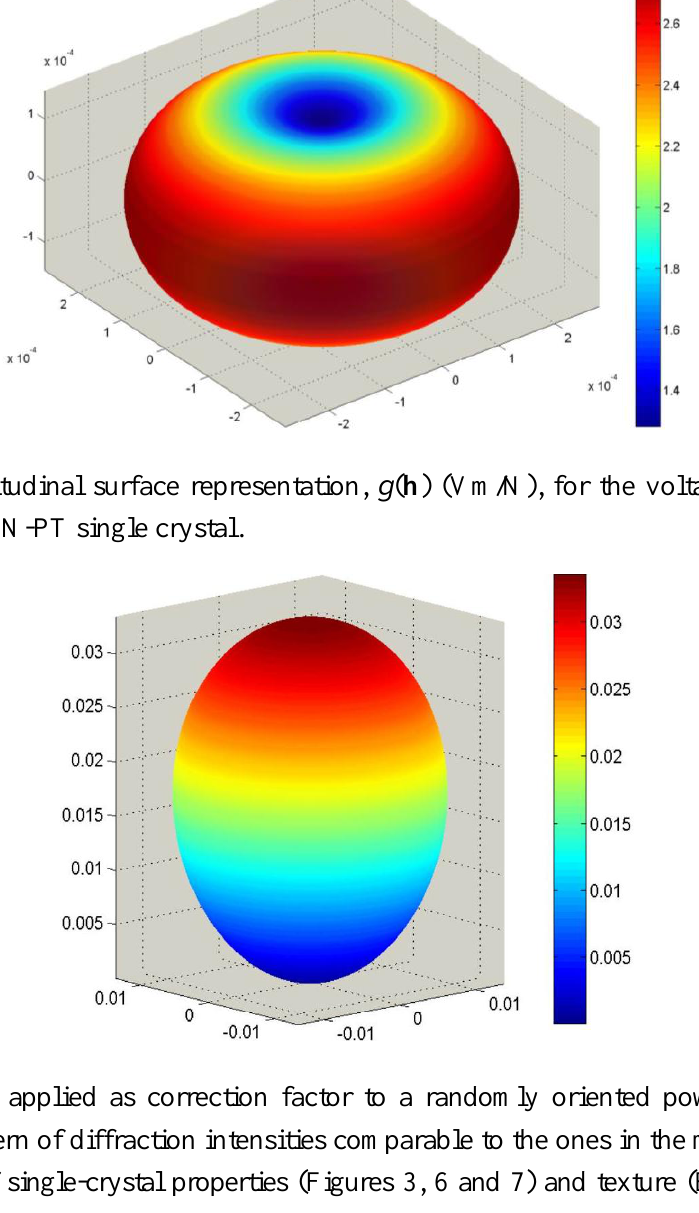
β T ( h ), for the impermittivity of a 0